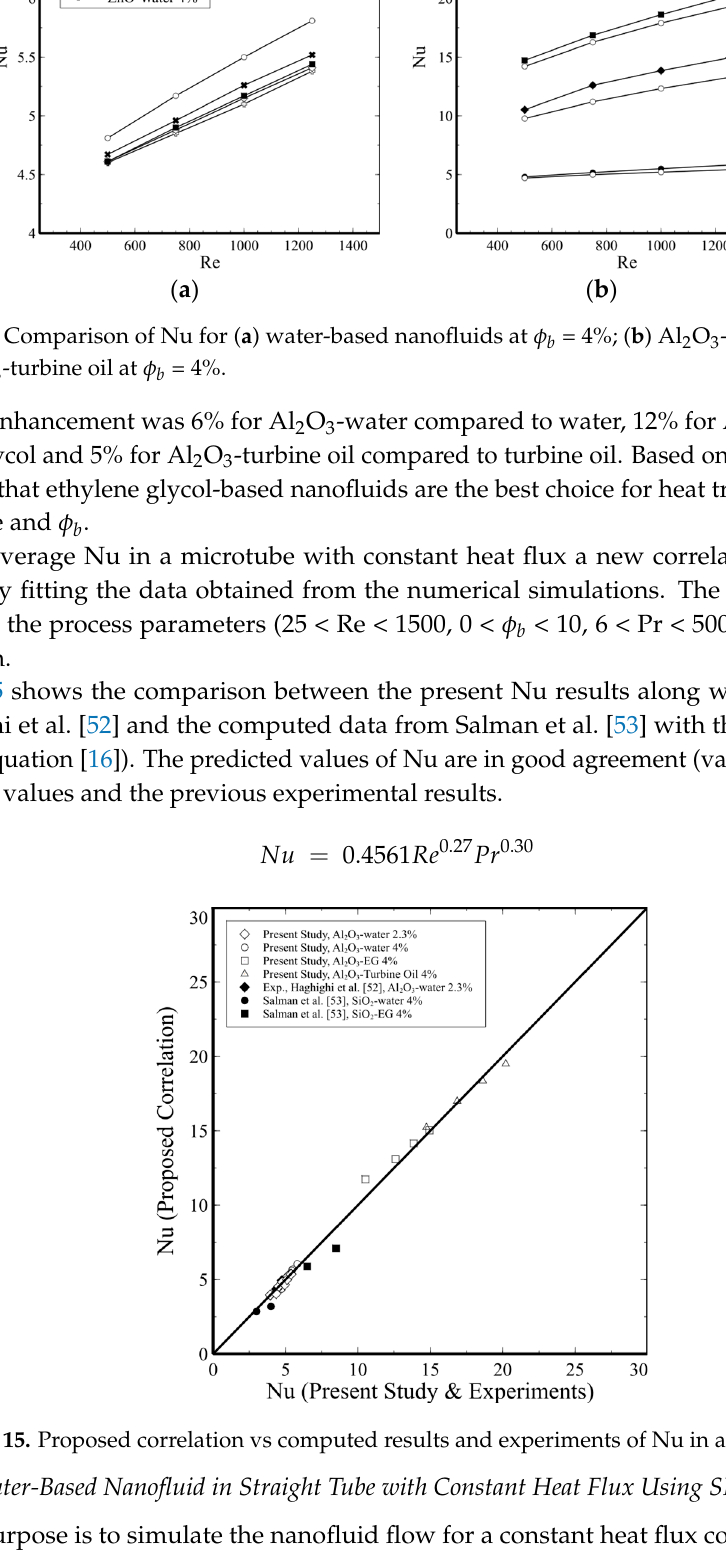
Figure 15. Proposed correlation vs computed results and experiments of Nu in a straight tube.